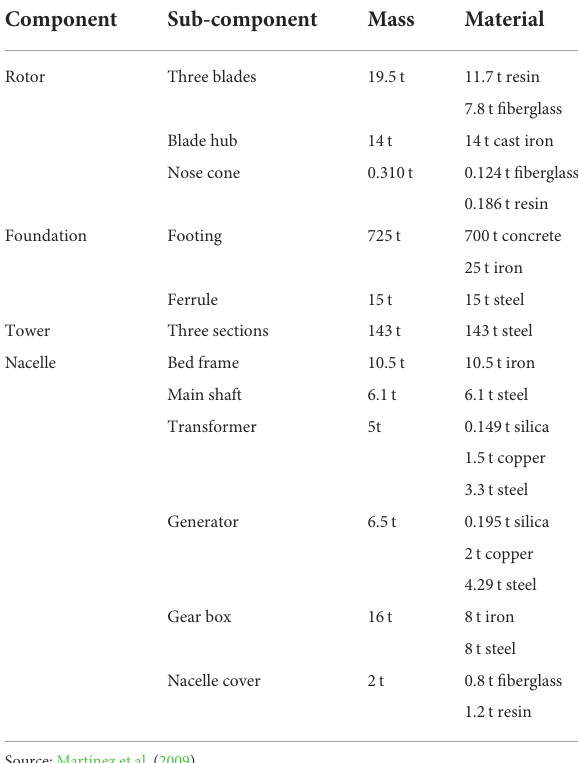
TABLE 1 Wind turbine